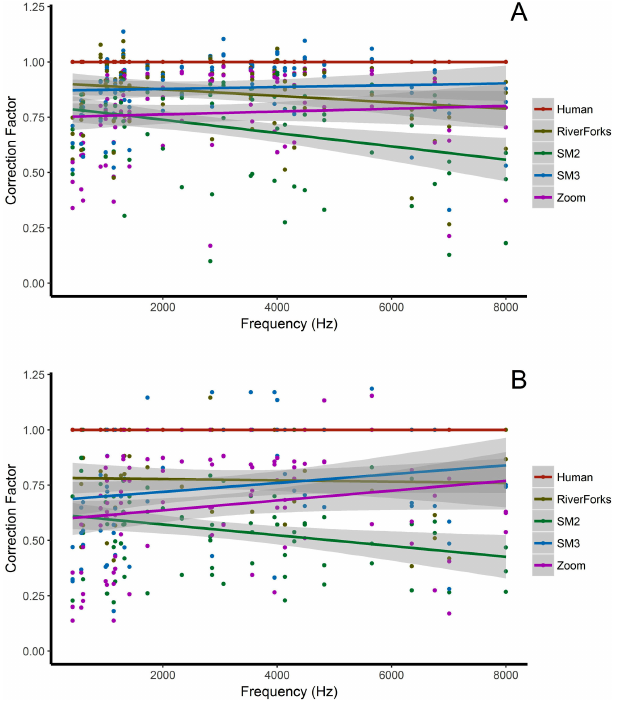
Fig. 2 . Correction factors for (A) EDR and (B) MDD of various ARU types at different frequencies. ARUs are in comparison to human detection as a reference. Correction factors are calculated using a ratio of detection area of ARU to detection area of a field observer (Appendix 1, 2). Correction factors less than 1 mean smaller detection distances than human observers in the field and can be applied to ARU data to standardize it with data from